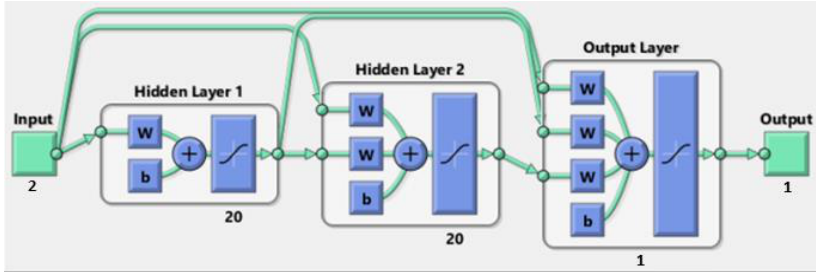
Figure 13. ANN Model for Regulated Voltage.